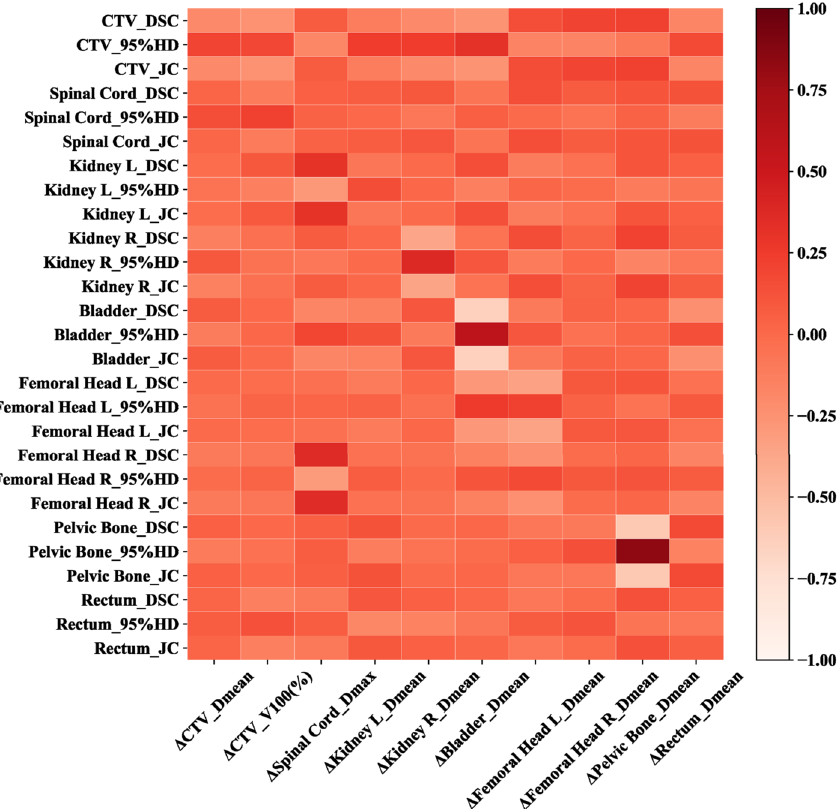
Figure 6. The heatmap of Spearman’s correlation analysis between all the geometric metrics and dosimetric differences for EBRT planning